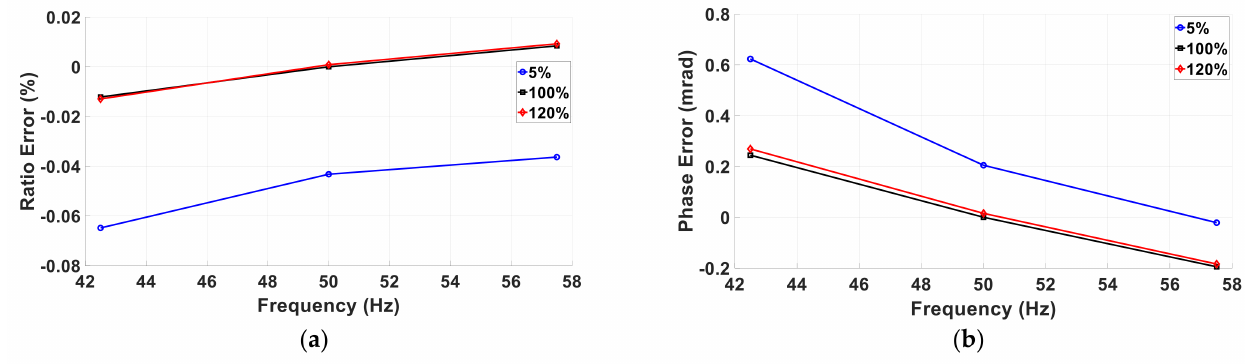
Figure 5. Ratio ( a ) and phase ( b ) errors of the VT under test at different fundamental amplitudes and frequencies.